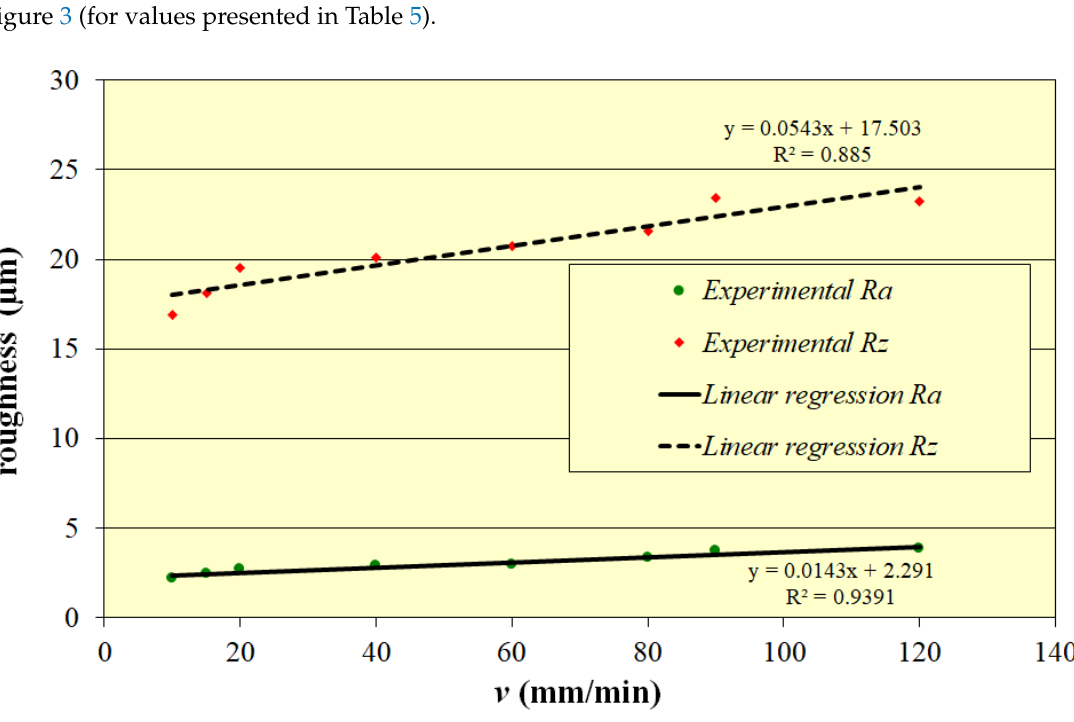
Figure 3. Roughness dependence on traverse speed with linear regression (graph). The summary regression models for factors x 1 ( m a ), x 2 ( p ) and x 3 ( v ) can be written